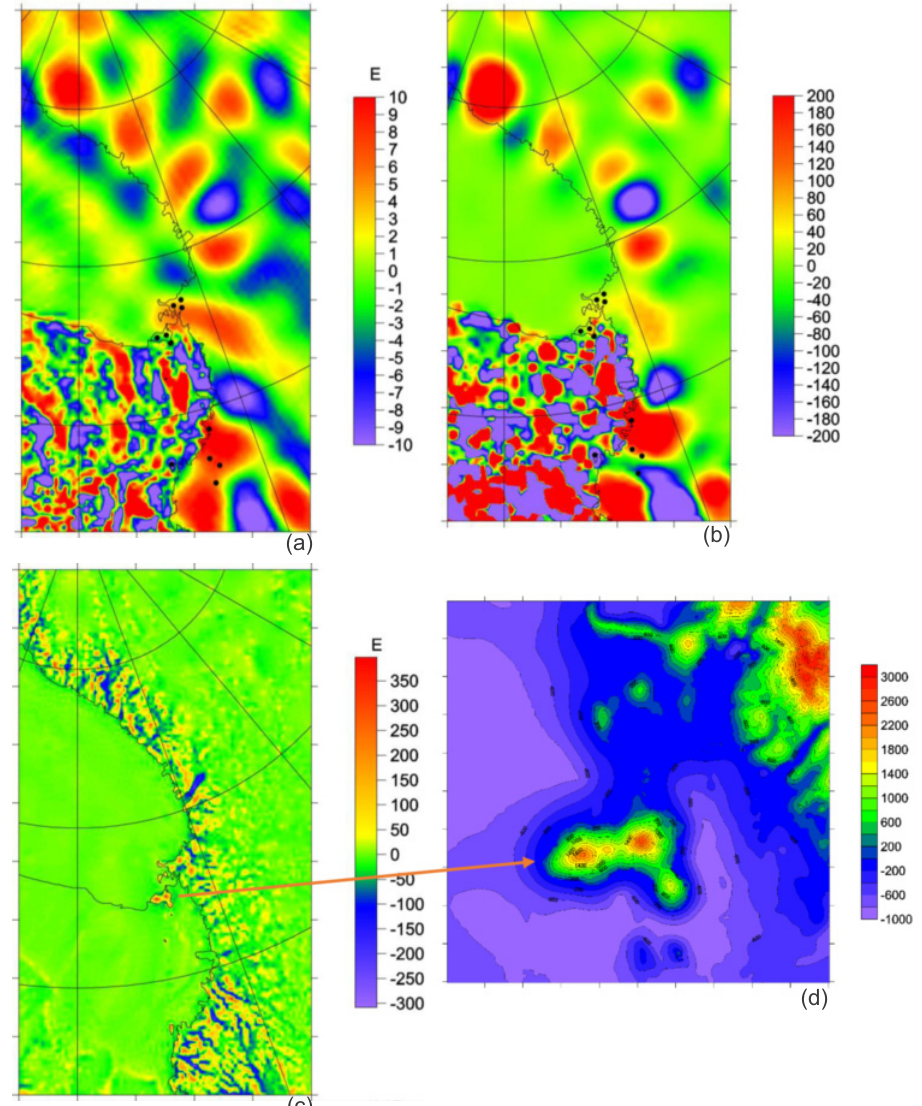
, (b) I , (c) the RAT14 combination of the gravity from the EIGEN 6C4 and the topography from the Bedmap2 Figure 12. Segment 1: (a) T zz 2 , (d) the Ross Island topography in T zz